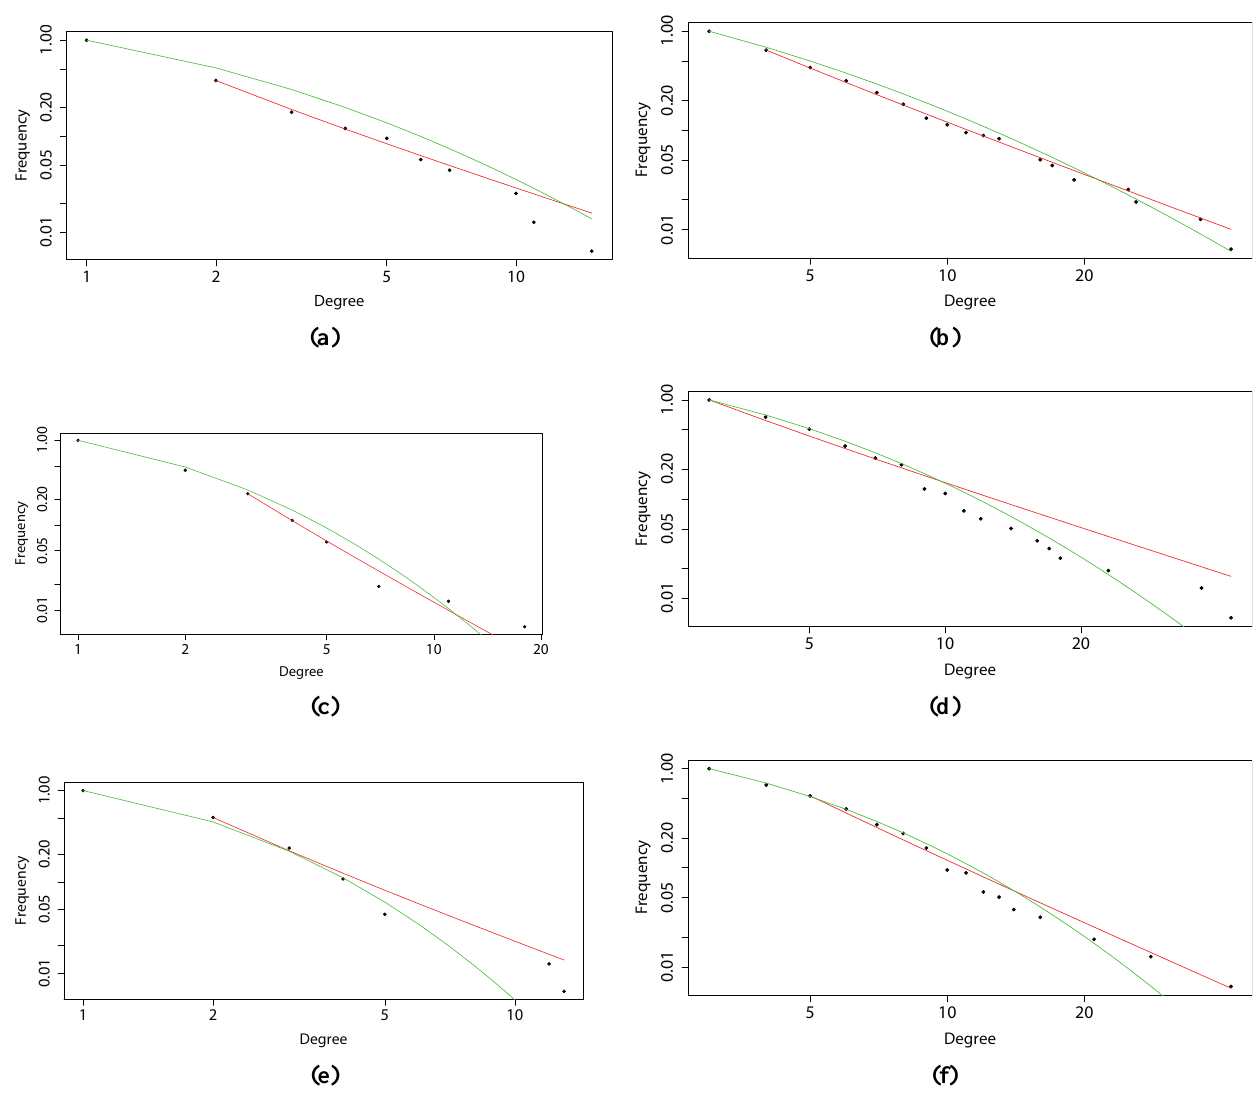
Figure 4. Degree distributions (with fitted power law and log-normal distribution) for: ( a ) a minimally-spanning tree based on correlation; ( b ) a planar maximally-filtered graph based on correlation; ( c ) MST based on mutual information; ( d ) PMFG based on MI; ( e ) MST based on partial mutual information; and ( f ) PMFG based on